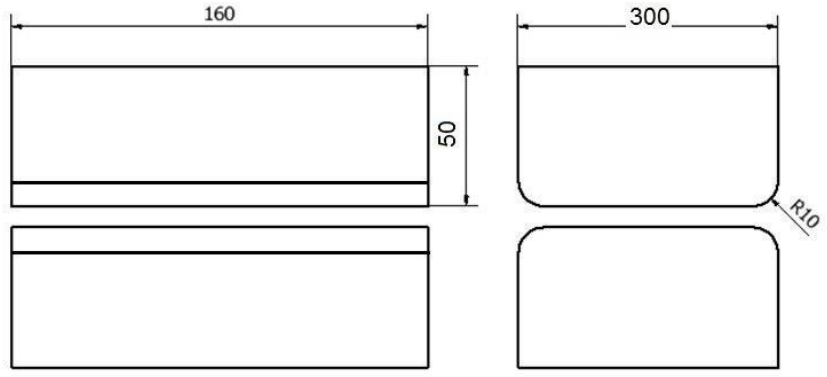
Figure 1. Shape and dimensions of rhombic flat anvils used to deform the zirconium alloy.